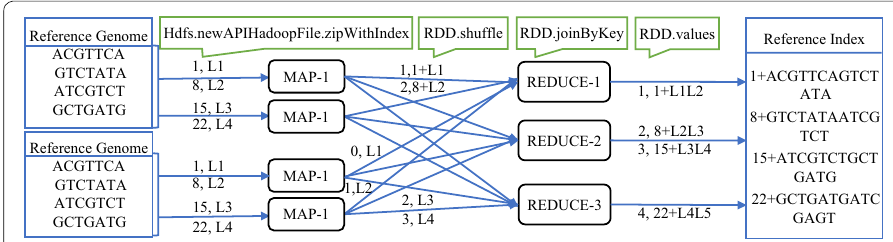
Fig. 2 Mapreduce architecture for Phase I (reference